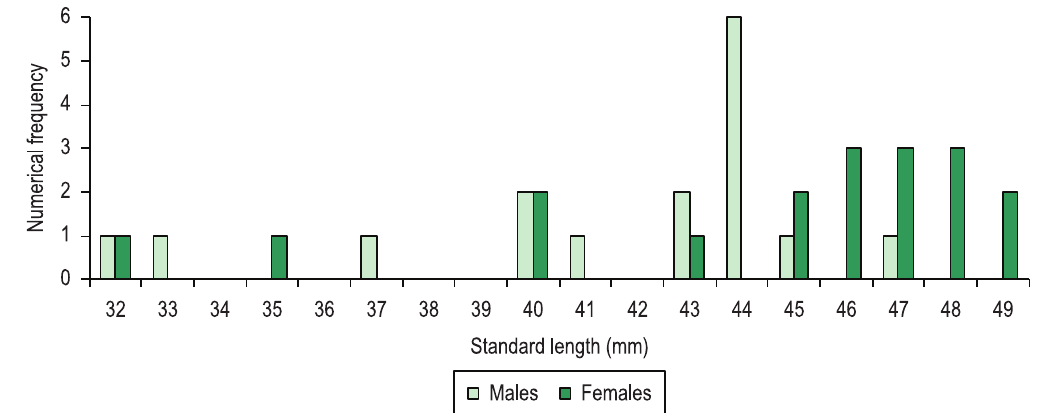
Figure 1. Standard length (mm) distribution of Serrapinnus heterodon individuals (males and females), from Mogi Guaçu